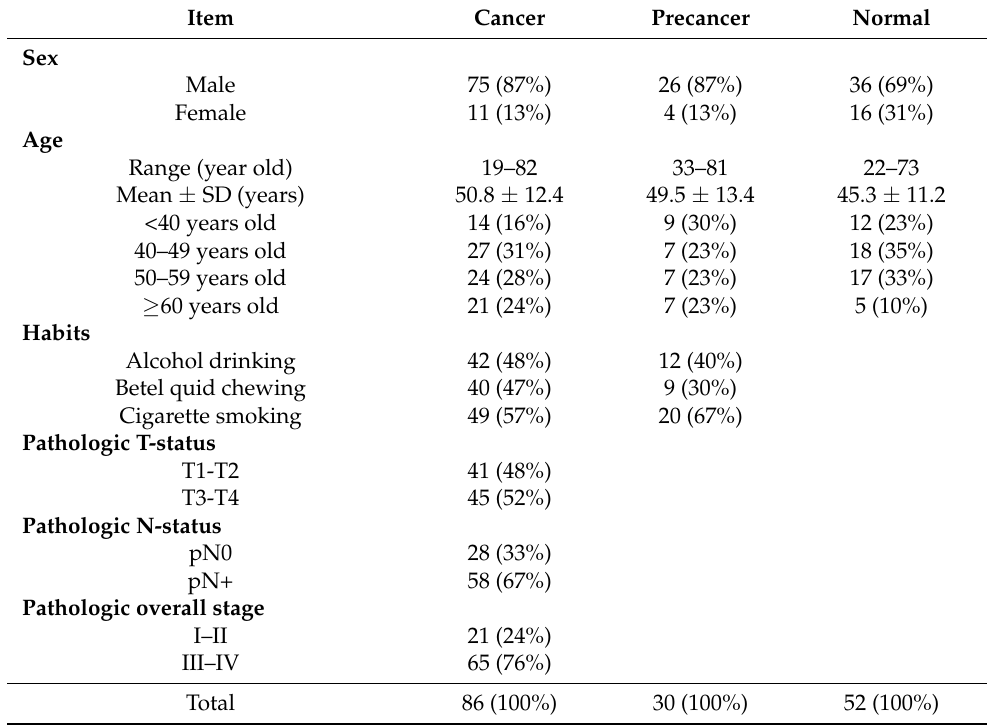
Table 1. Clinical characteristics of the individuals that participated in this